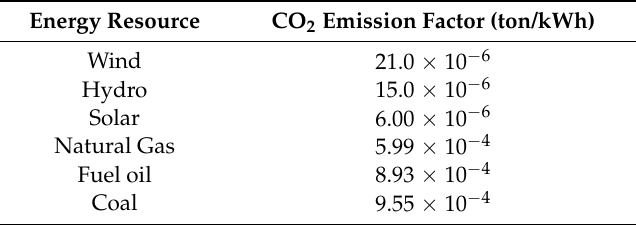
Table 1. CO 2 emission factor “ α ” for different energy resources